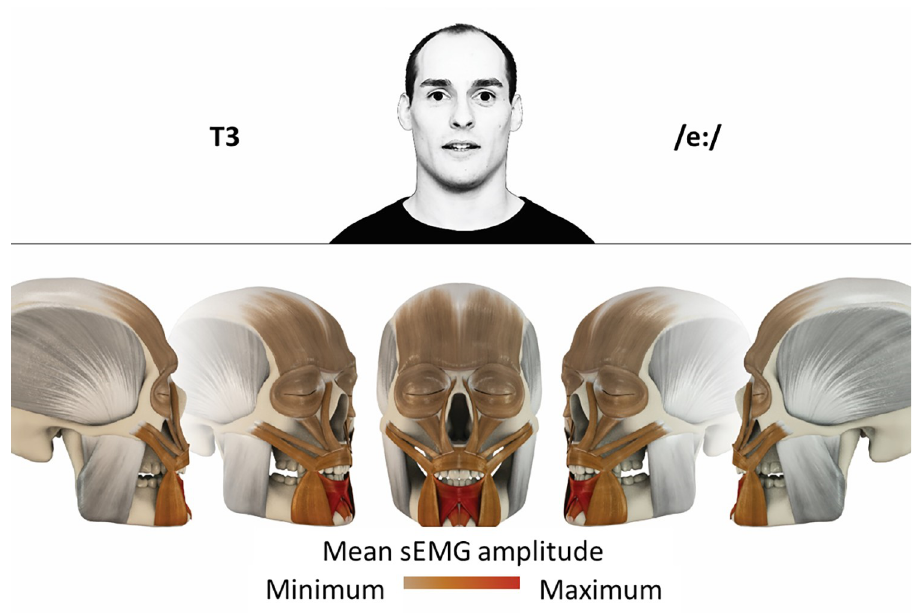
Fig 4. Color-coded facial muscle activation pattern of task T3. Pronouncing the German vowel: E/e ː /. Animation by Jonas Laustro¨er.